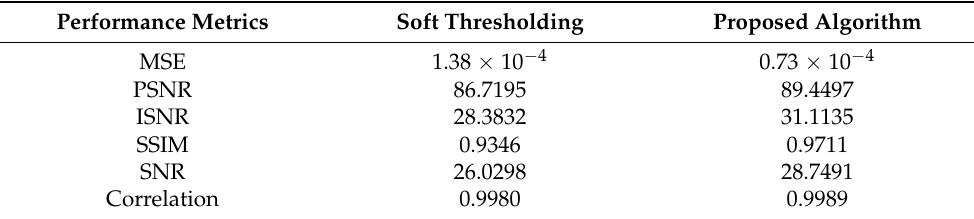
Table 3. Performance comparison of different sparsity transforms using mean squared error in the transform domain. Temporal FFT performs better in cardiac Cine